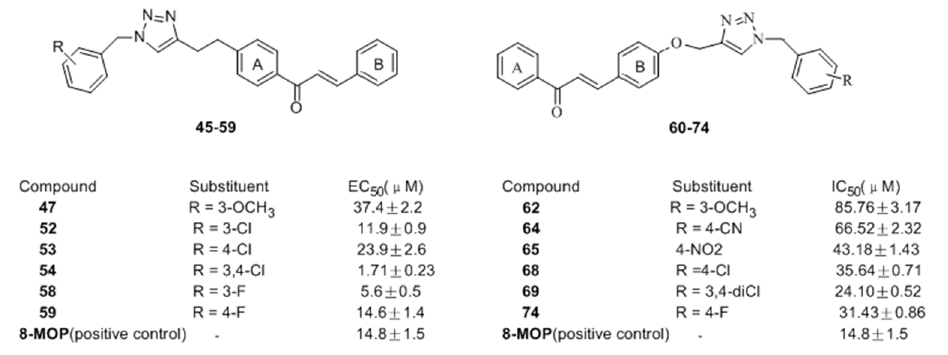
Figure 9. Structures of the chalcones derivatives bearing1,2,3-triazole moieties.